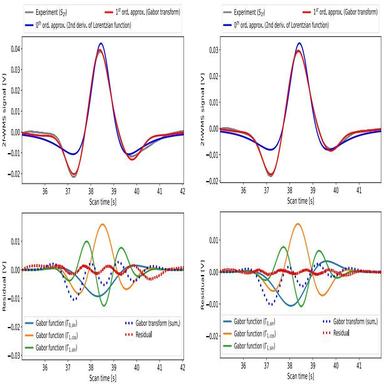
Experimental data and results of denoising post-procedure (baseline correction followed by line-shape fitting based on the set of Gabor functions) for Scenario C at different oxygen concentration levels: 100 % air (left panels); 75 % air + 25 % CO2 (right panels). Residual of the Gabor transform is depicted in red (dotted line). Blue dotted line represents the product of selected envelope function (Gausian profile) and a sum of three goniometric (sine and cosine) functions (depicted as turquoise, orange, an